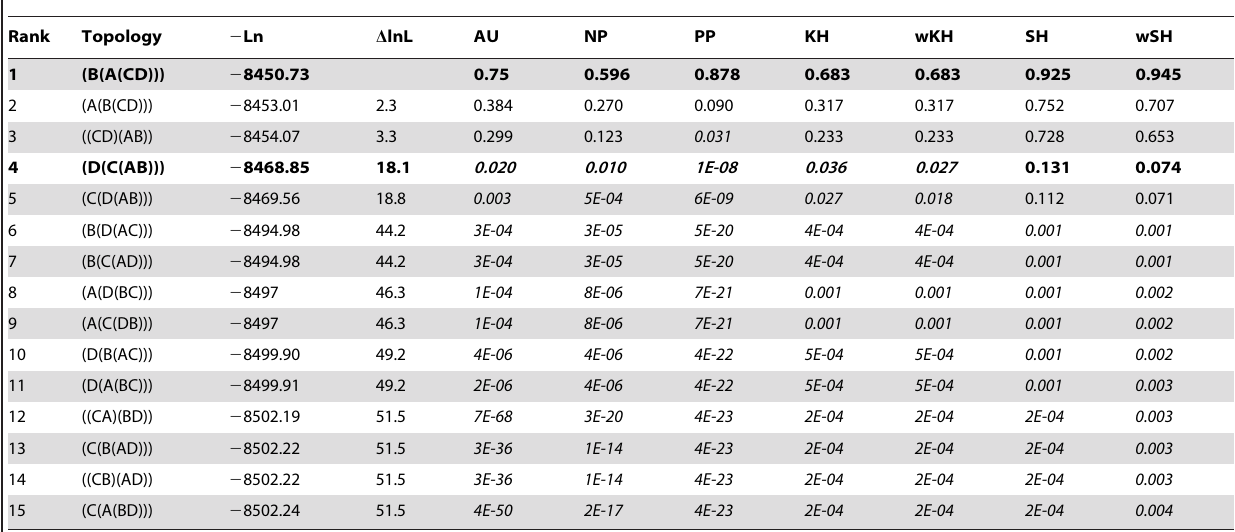
Table 4. ErbB family cluster duplication topology tests.